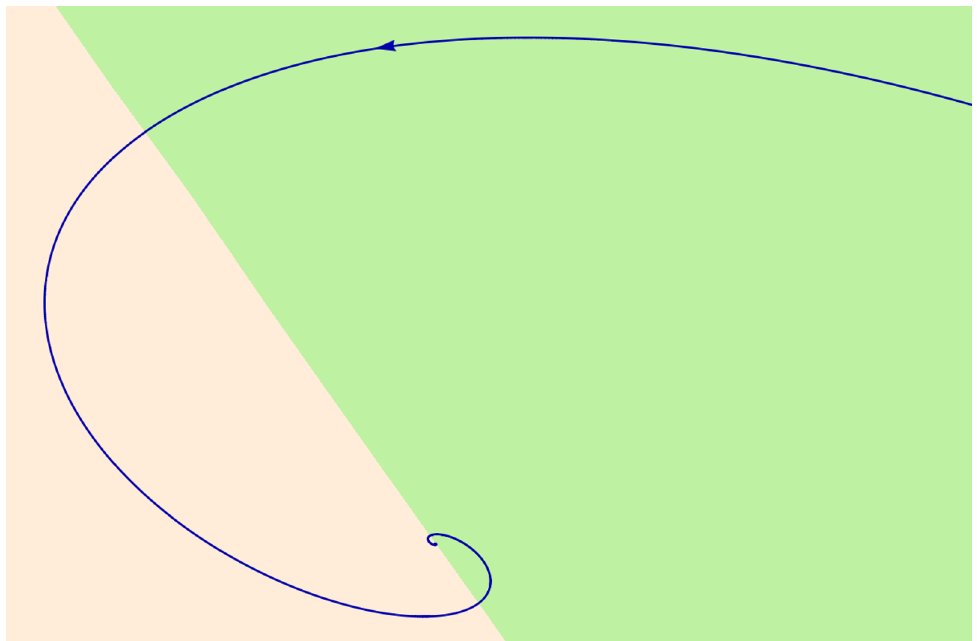
Figure 5 . Example of a spiraling trajectory around p 1 in the ( m, k ) -compactification. region at some point p 00 , then enter again at some point p 000 , and so on, as they spiral into asymptotically at future infinity, see figure 5. This asymptotic spiraling corresponds p 1